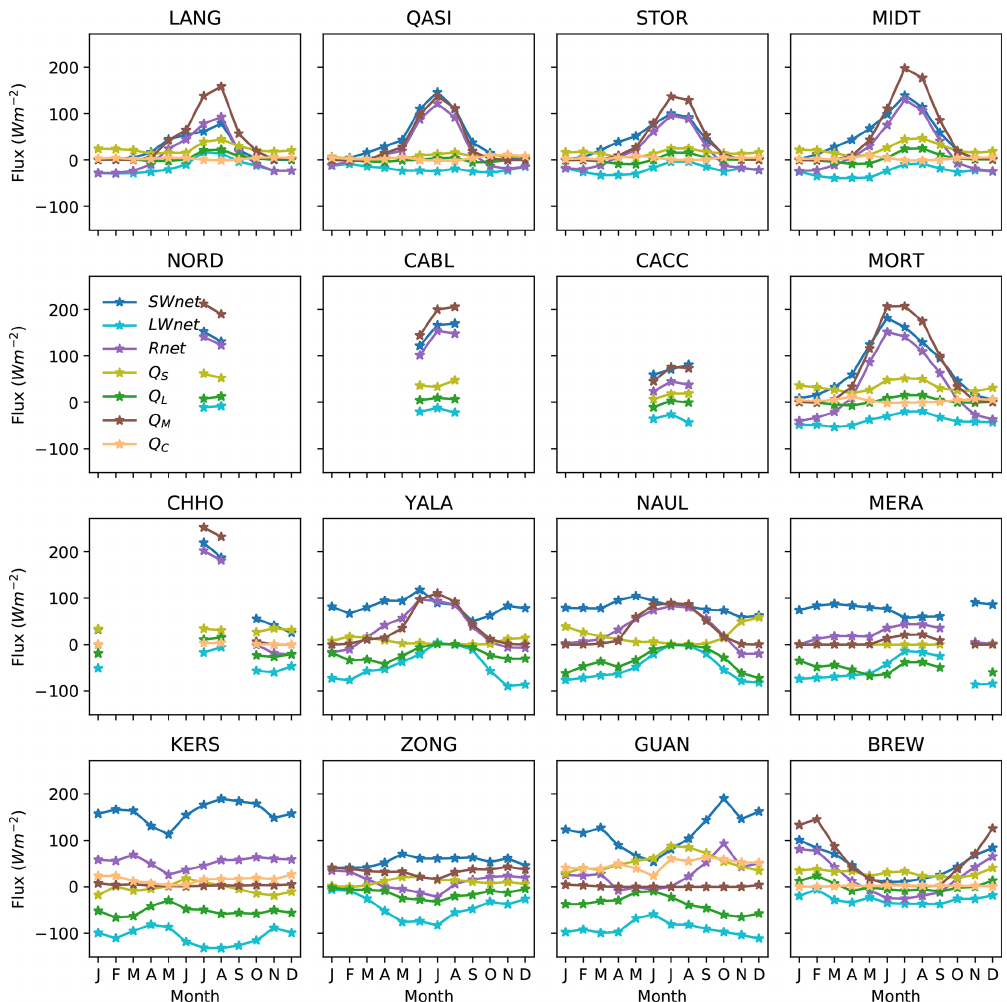
Figure A2. Monthly average SEB fluxes at each site. Note that the monthly value is only shown for a site if it has > 10 complete days in a month across the full